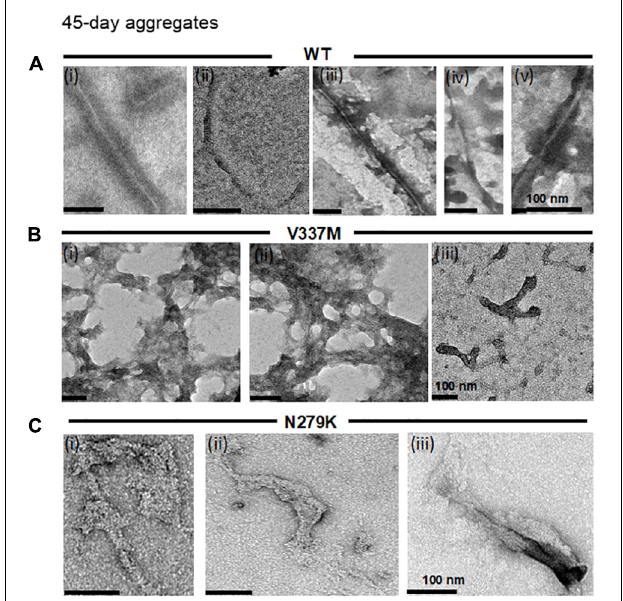
FIGURE 3 | The distinct structural phenotypes of tau K18 aggregates observed in the presence of the FTD mutations do not change with extended aggregation reactions. (A) K18-WT formed PHFs and SFs, similar to those recorded in the 4 days assay in Figure 2A . (B) K18-V337M formed amorphous aggregates in addition to short filaments, similar to those observed in the 4 days aggregation assay in Figure 2B . (C) K18-N279K formed thick filament bundles whose structural features shares major similarities with those in Figure 2C . Scale bar = 100 nm for all images. Three independent experiments each performed with a different batch of purified